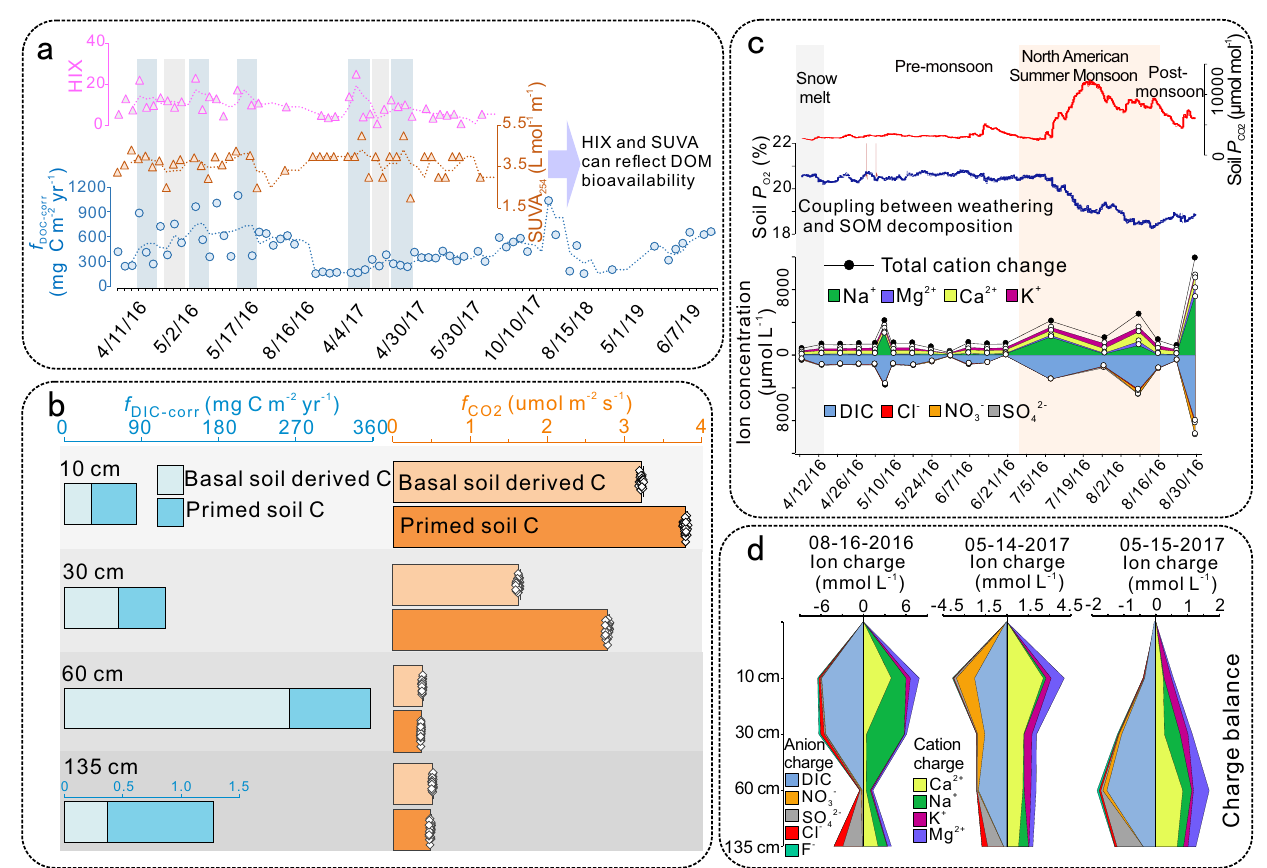
Fig.4|Timeseriesanddepthvariation.a Timeseriesofhumi fi cationindex(HIX), speci fi c ultraviolet absorbance at 254nm (SUVA 254 ) and corrected dissolved organic carbon (DOC) fl uxes ( f DOC-corr ) in the topsoil. HIX, SUVA 254 and f DOC-corr show generally consistent temporal trends. b The priming effect (PE) at four soil depths. The periods for calculation are marked by yellow bands in Fig. 3 and SupplementaryFigs.7 – 9.Theprimingeffectiscalculatedusingcorrecteddissolved inorganiccarbon(DIC) fl uxes ( f DIC-corr ) and CO 2 fl uxes ( f CO2 ) data,with lighter blue or orange representing basal soil-derived C fl uxes and darker blue or orange